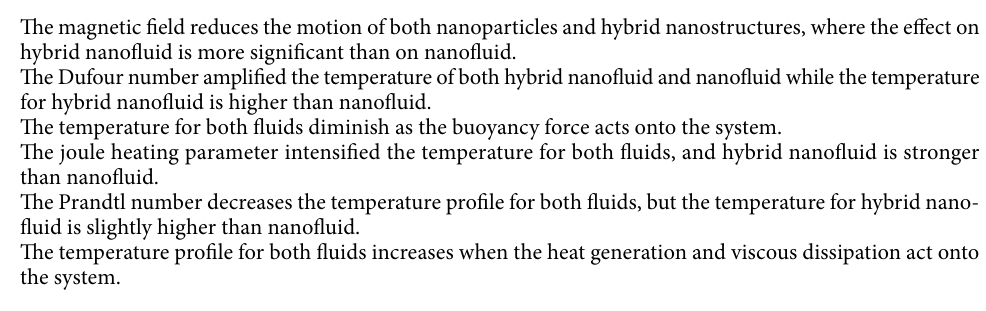
Figure 8. Influence of Du on θ when ( Gr ) t 0.5 M =